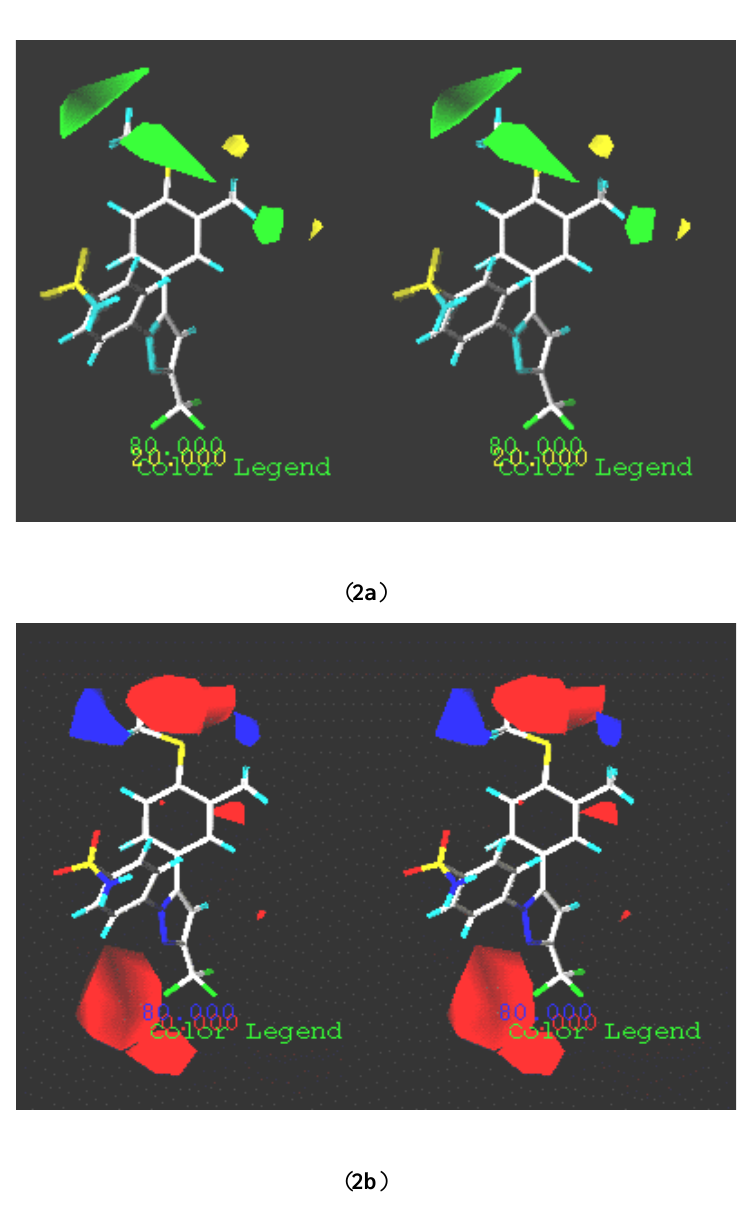
Figure 2. Stereoviews of steric (a) and electrostatic (b) CoMFA contour plots for pyrazole 1 . (a) Bulky substituents enhance activity in the regions shaded green and depress activity in the yellow regions. (b) Electropositive substituents enhance activity in the regions shaded blue and depress activity in the red